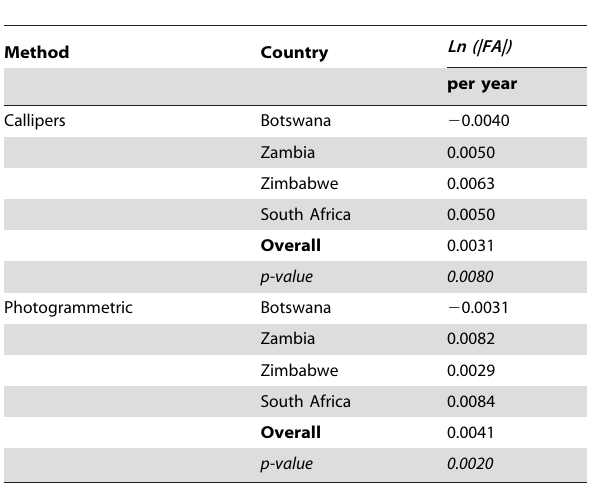
Table 1. Estimated rates of change in fluctuating asymmetry from mixed effects models of ln (2|L 2 R|/(L + R)) over time for photogrammetric and calliper measures.